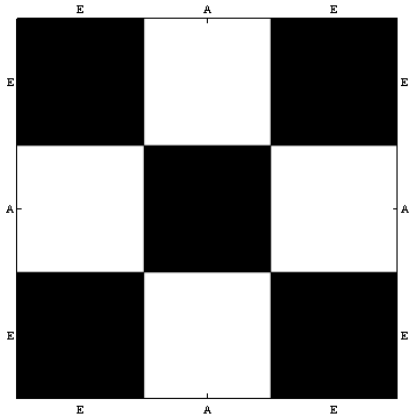
Figure 4. Recurrent patch for the text EAEBECEAECD.